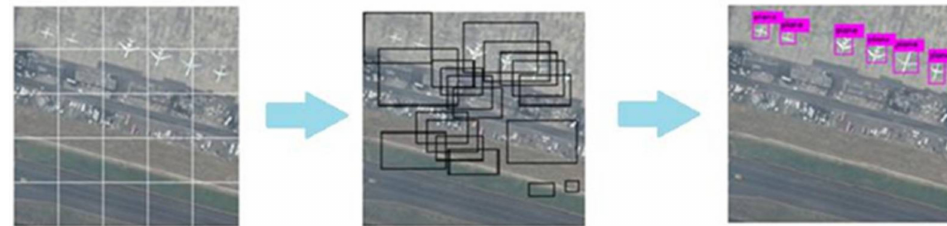
Figure 5. YOLO model divides image into S × S grid and calculates confidence scores with B bounding boxes and predictions are enclosed into (S × S) × (B *5 + C) tensor.